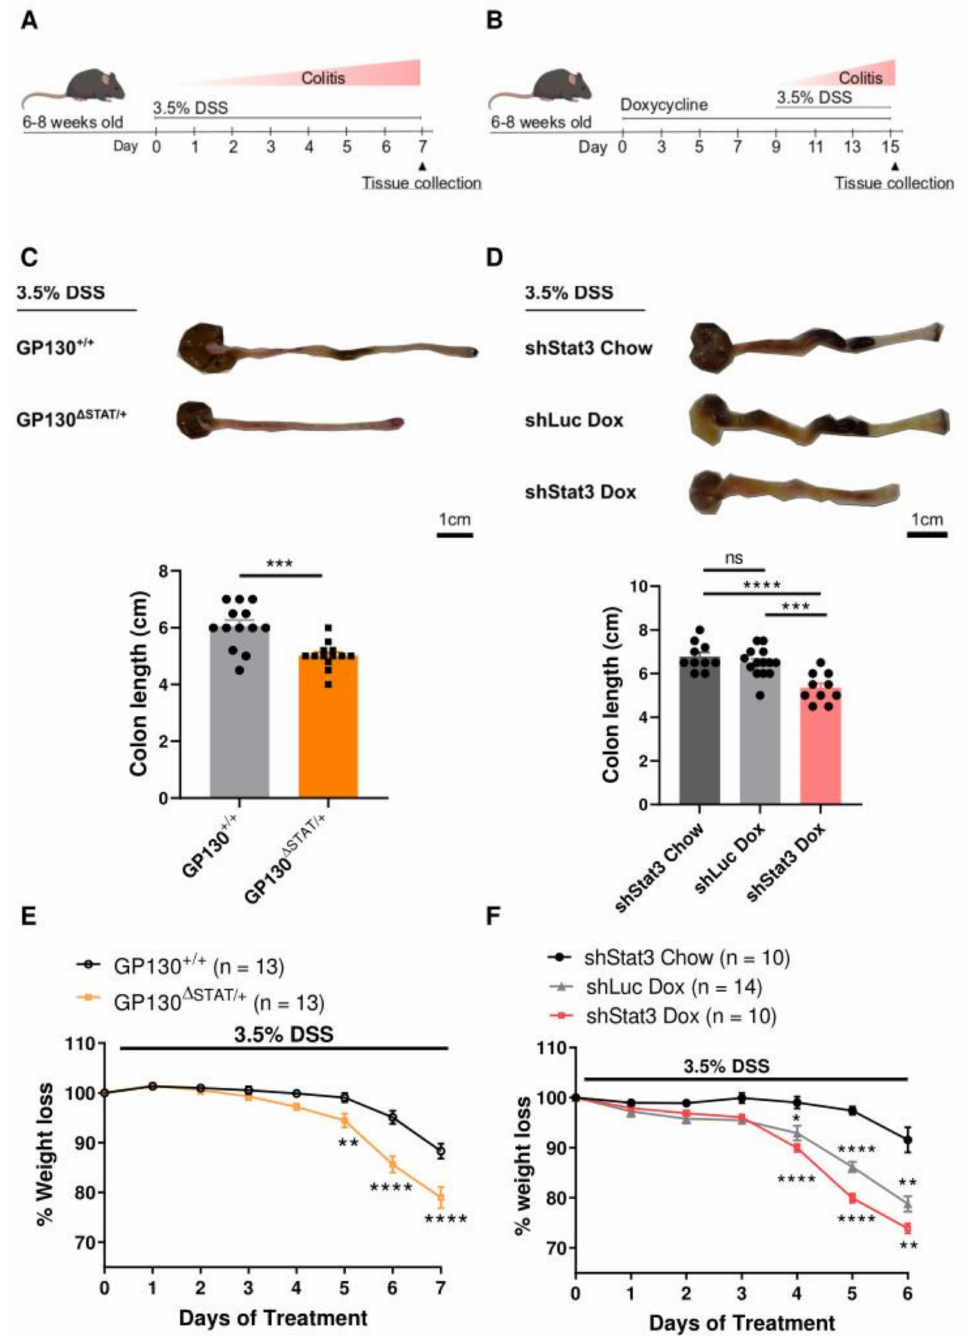
Figure 1. Mice with reduced STAT3 activity are highly susceptible to chemically induced colitis: ( A ) GP130 ∆ STAT/+ and GP130 +/+ controls were challenged with 3.5% dextran sulfate sodium (DSS) to induce colitis ( n = 13 for each genotype). ( B ) shStat3 and shLuc controls either received standard chow or doxycycline diet for 9 days to induce short hairpin-driven Stat3 silencing prior to DSS treatment ( n = 10–14 for each experimental group). Experimental endpoint was determined by a 20% loss of initial weight. ( C , D ) Representative images and measurements of colon lengths from each cohort after DSS treatment. ( E , F ) Percentage of body weight loss during exposure to 3.5% DSS. Each symbol represents the data from an individual mouse and pooled across 3 independent experiments, mean ± SEM. Data were checked for normal distribution with Kolmogorov–Smirnov test and statistical analysis was performed using ( C ) unpaired Student’s t -test; ( D ) one-way ANOVA with Tukey’s multiple comparisons test; ( E , F ) mixed effects analysis with Bonferroni correction. * p < 0.05; ** p < 0.01; *** p < 0.001, **** p <